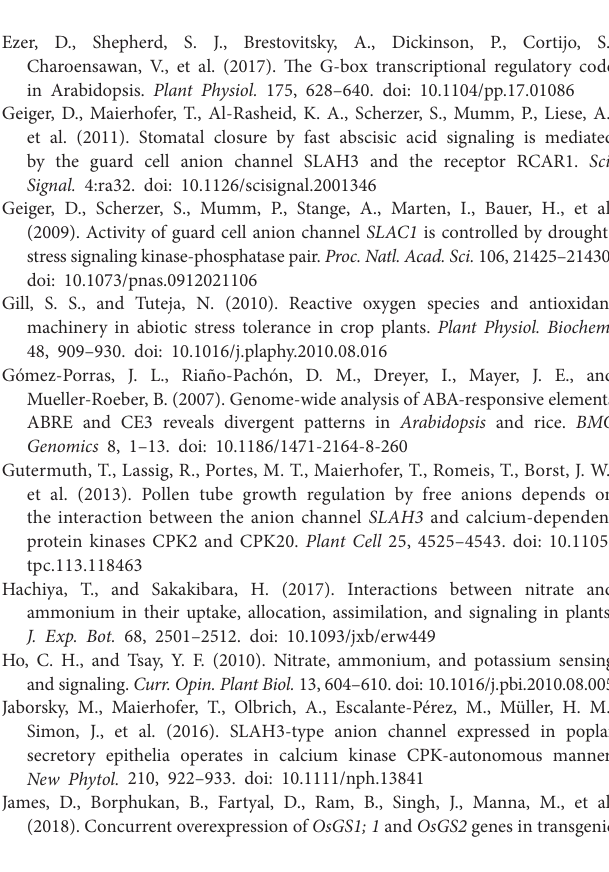
Supplementary Figure 1 | Amino acid alignment of MeSLAH4 protein in cassava, and Os05g0269200 protein in rice. Here, MANES ( Manihot esculenta ) MeSLAH4 amino acid sequence was the query sequence and it was aligned with Os05g0269200 amino acid sequence. Supplementary Figure 2 | Conserved motifs of SLAH genes. Here, MANES ( Manihot esculenta ), At ( Arabidopsis thaliana ), and Os ( Oryza sativa ) genes and their motifs are depicted. Various color represents different motifs. The lengths and positions of the colored blocks correspond to the lengths and positions of motifs in the individual protein sequences. The scale indicates the lengths of the proteins as well as the motifs. Supplementary Figure 3 | Sequence logos of the conserved motifs of SLAH genes. Over-represented motifs were identified using the MEME tool. The stack’s height indicates the level of sequence conservation. The heights of the residues within the stack indicate the relative frequencies of each residue at that position. Supplementary Figure 4 | Identification of transgenic rice lines. Lane 1–7 is a single transgenic strain of rice (35S:MeSLAH4OE-4), − WT control, + is MeSLAH4